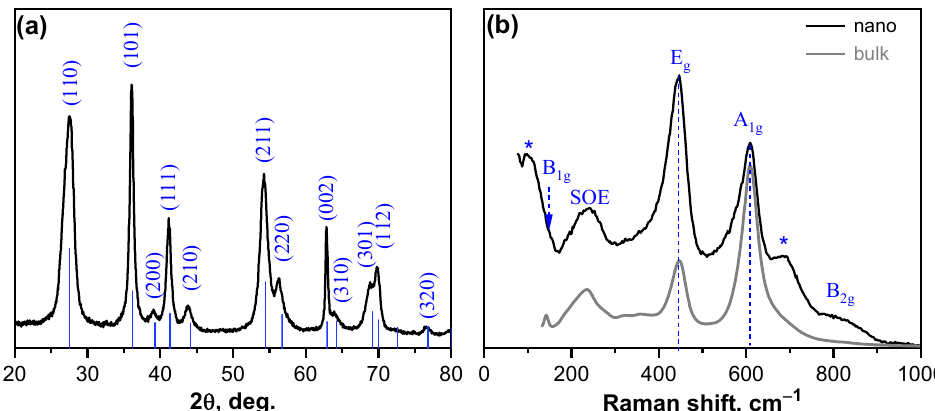
Figure 1. PXRD pattern of the rutile TiO 2 nanocrystals, theoretical XRD pattern of rutile reference from ICSD (# 202241)—( a ), Raman spectra of the r -TiO 2 nanocrystals synthesized in present work and bulk rutile TiO 2 from RRUFF database (R110109)—( b ). * Scattering bands found in nanosized rutile